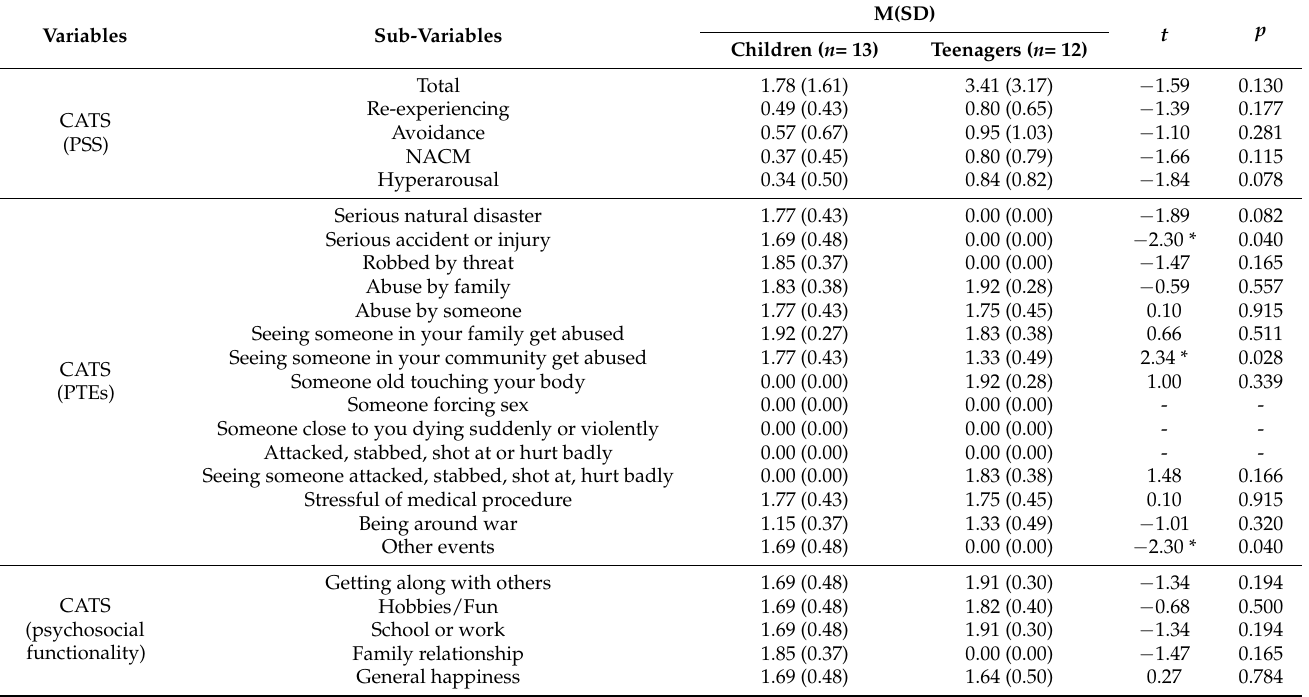
Table 4. The result of CATS (PSS), CATS (PTEs), and CATS (psychosocial functioning) between two population groups.